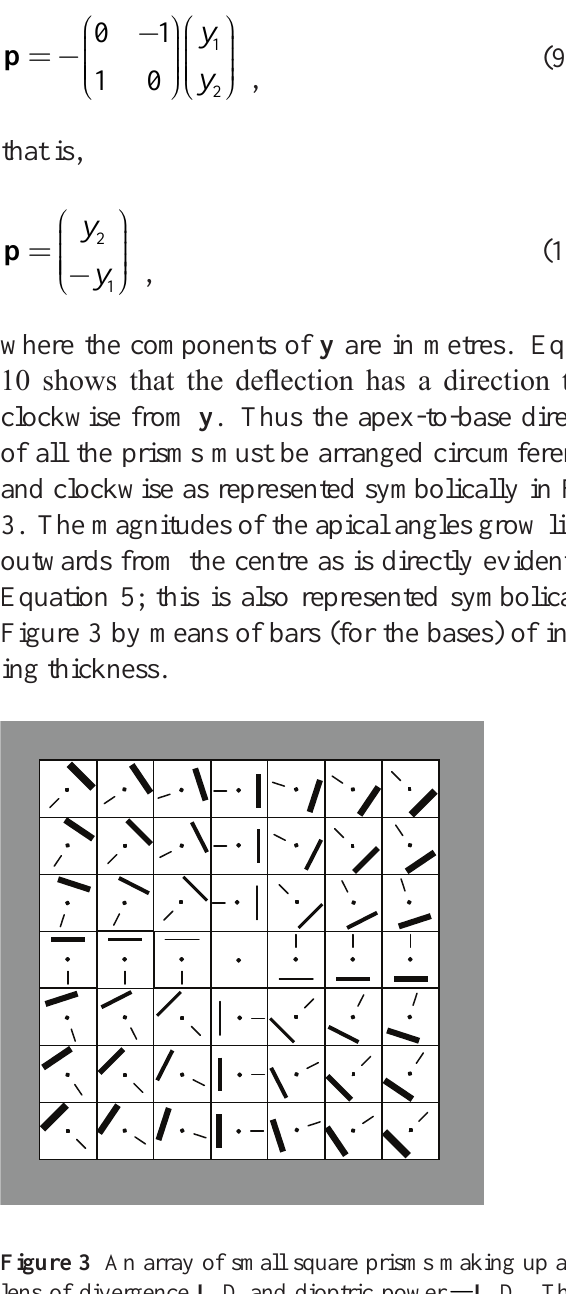
Figure 3 An array of small square prisms making up a square lens of divergence L D and dioptric power − L D. There are three marks on each prism: a dot marks the geometrical centre, a short line segment marks the direction of the apex and a longer line segment represents the base. The central square represents a prism of zero apical angle. The apical angle increases linearly with distance from the centre as represented symbolically by line segments of increasing thickness. The apex-to-base direction is circumferential and clockwise. Squares and their particular ar- rangement are chosen for illustrative purposes; other shapes and arrays are perfectly possible and are likely to be preferable in any actual realization of the lens.